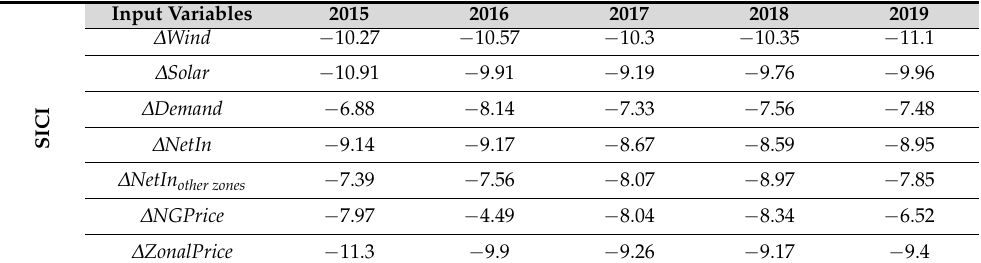
Table A5. Augmented Dickey–Fuller test statistics in 1st difference; SICI.